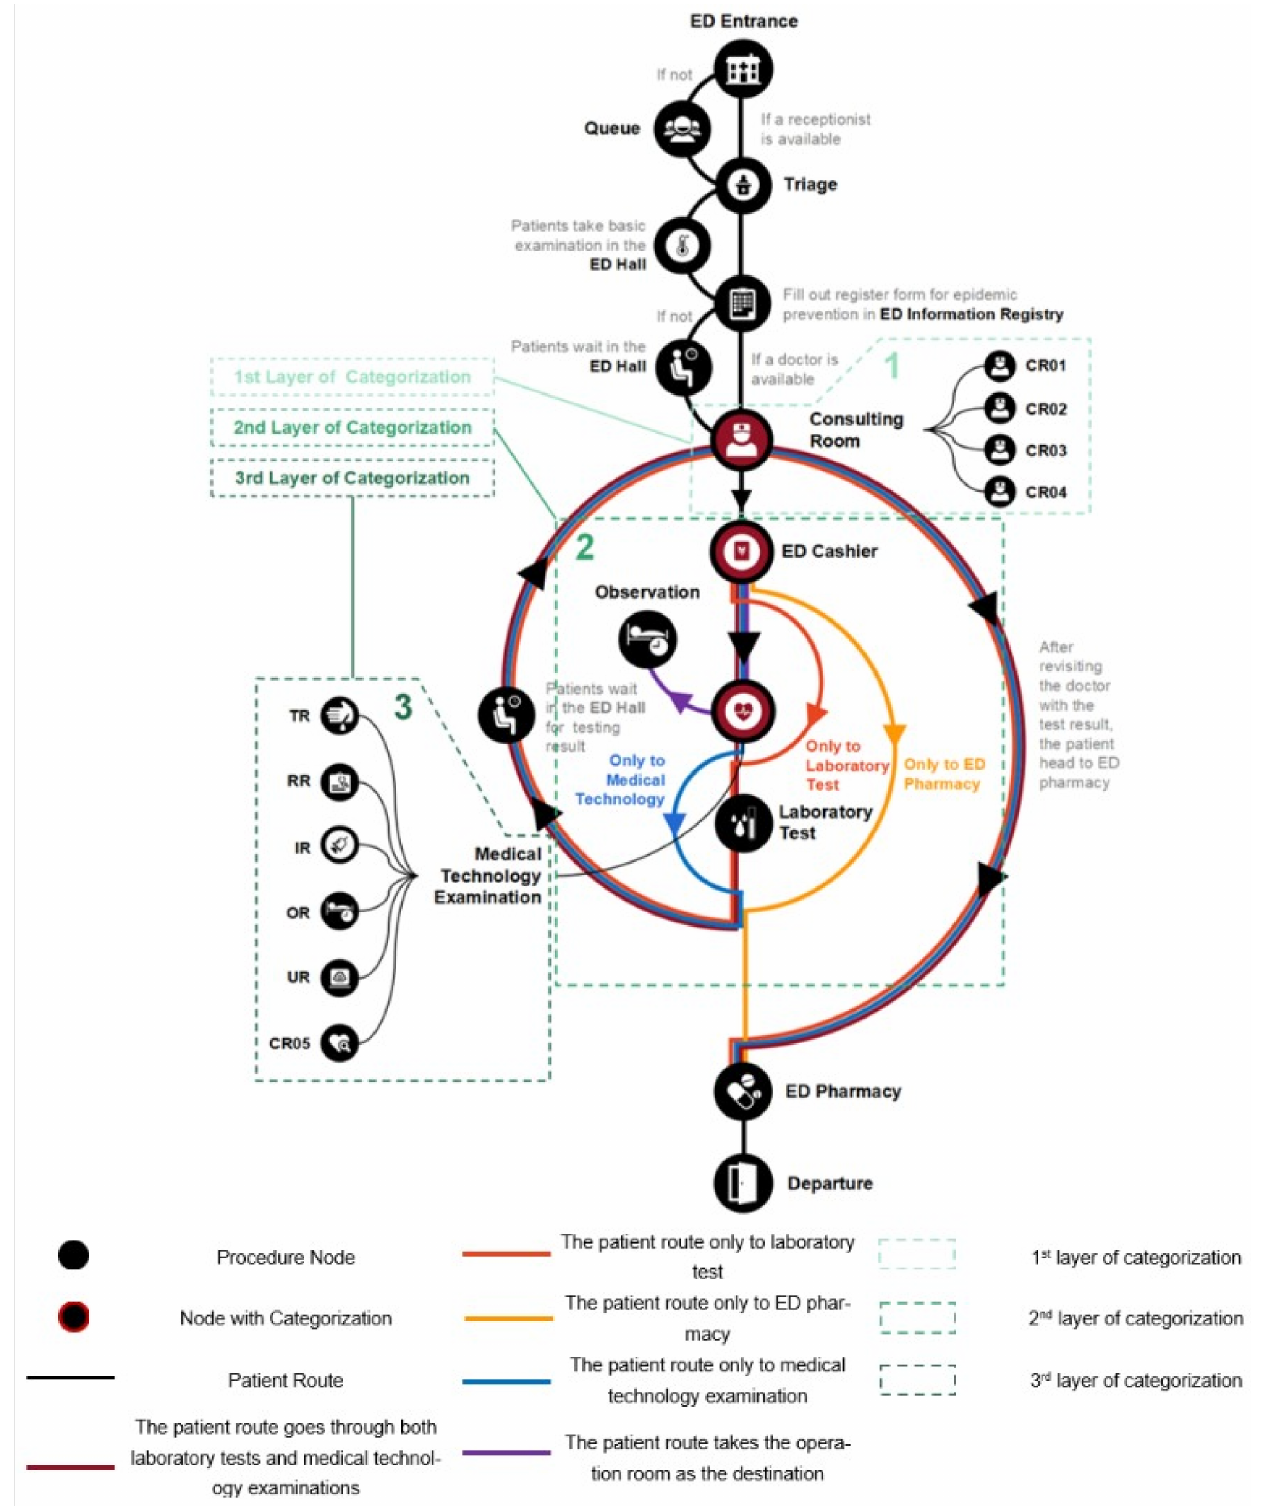
Figure 3. ED patient journey with corresponding